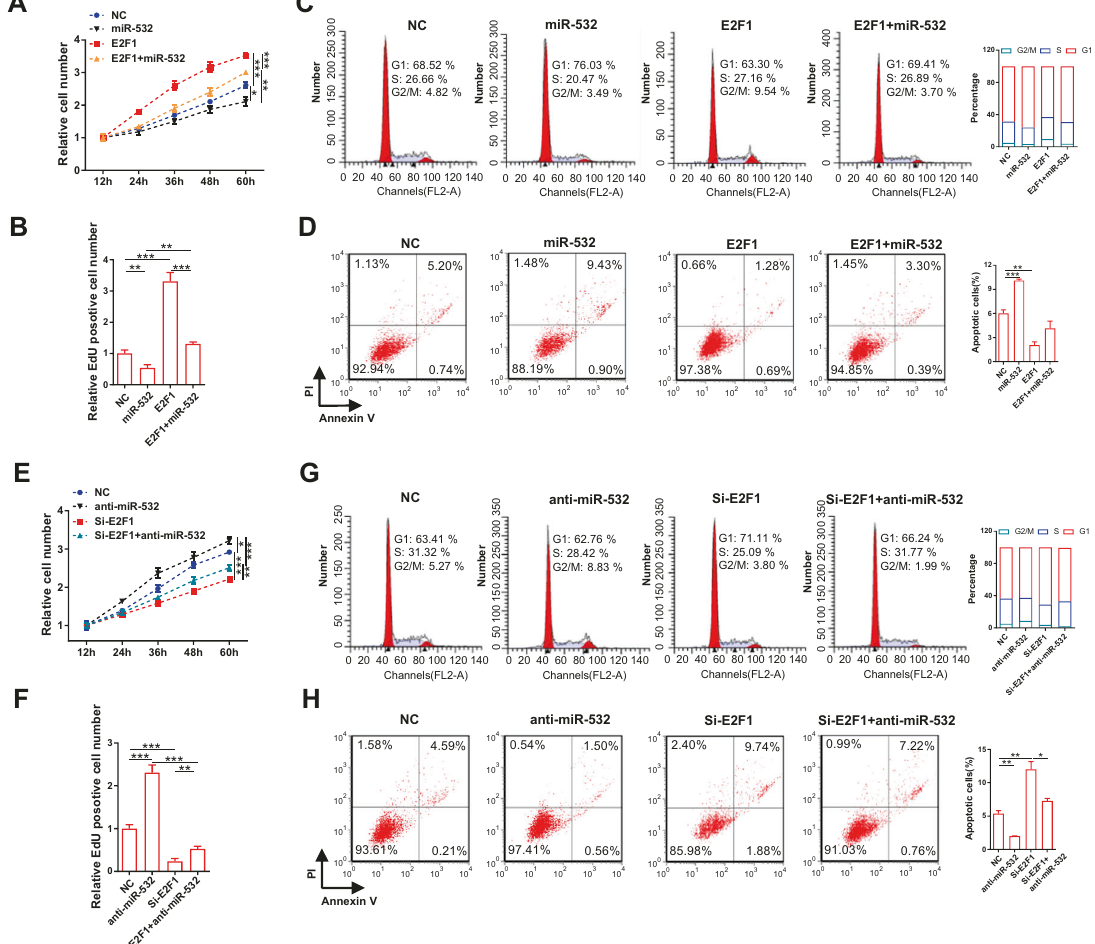
Fig. 5 miR-532 inhibits GC cell proliferation, G1/S transition and promotes apoptosis and DNA damage by suppressing E2F1 in vitro. A, B Cell proliferation assays (CCK8 and EdU) were performed in MKN-45 cells transfected with miR-532 mimics, E2F1 vector or E2F1 vector plus miR-532 mimics. A : CCK-8 assay; B : EdU assay. C, D Histogram statistics from cell cycle and apoptosis assays. E – H Analysis of cell proliferation, cycle and apoptosis in MKN-45 cells transfected with miR-532 inhibitors, si-E2F1 or si-E2F1 plus miR-532 inhibitors. * P <0.05; ** P <0.01; *** P <0.001.